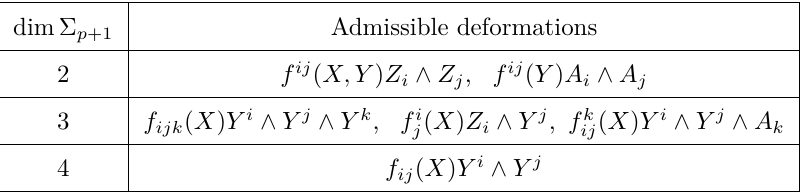
Table 2 . Admissible deformations of the general action functional S ( p +1) for special values of p . All deformations appear with a suitable function of the scalar fields of the theory, which we denote collectively by f (each being a different function). We observe that special cases appear only in low dimensions ≤ 4